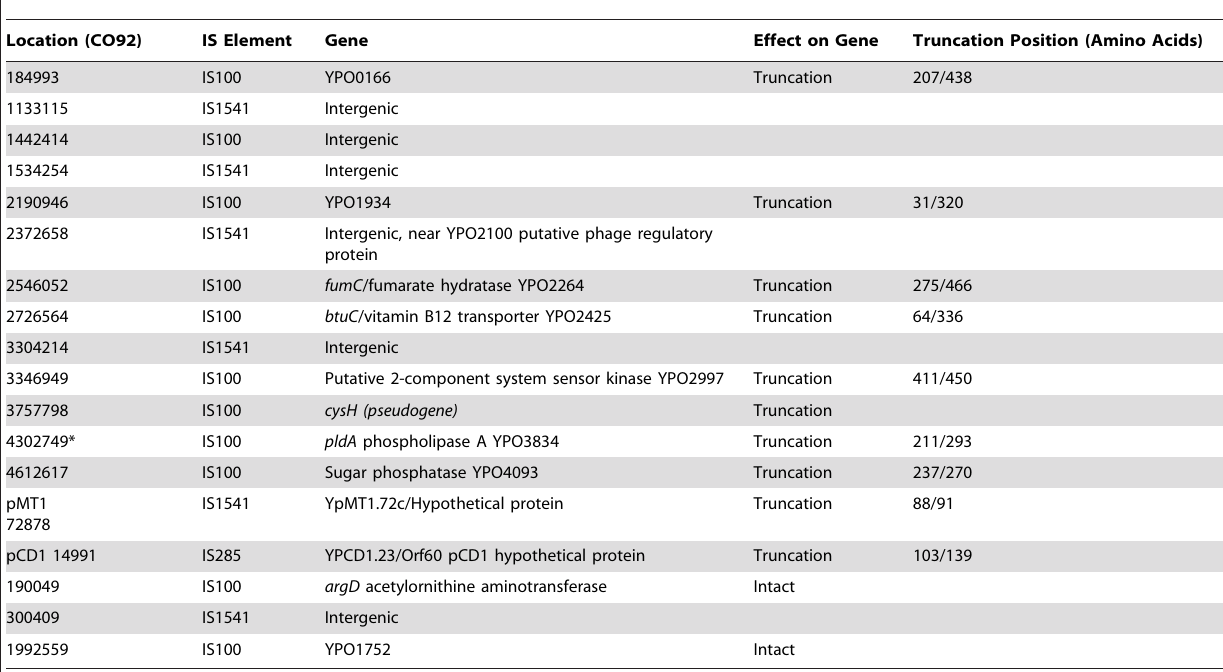
Table 3. IS Element Variation Between